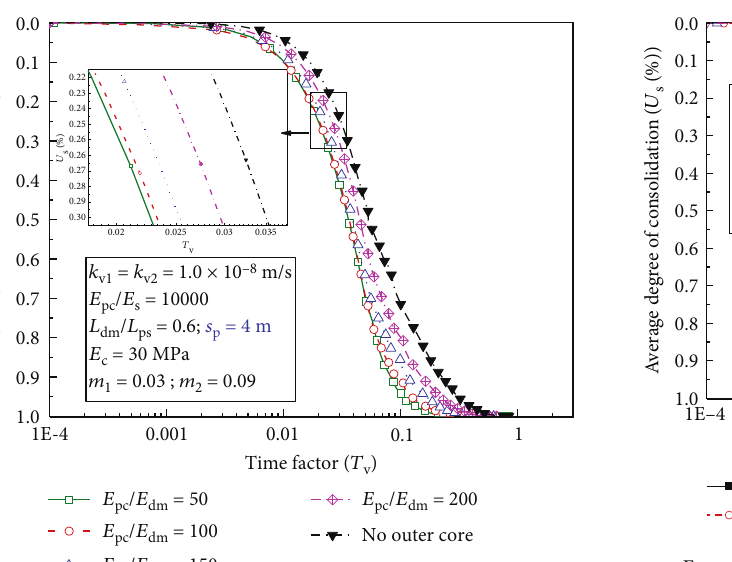
Figure 9: E ff ect of E